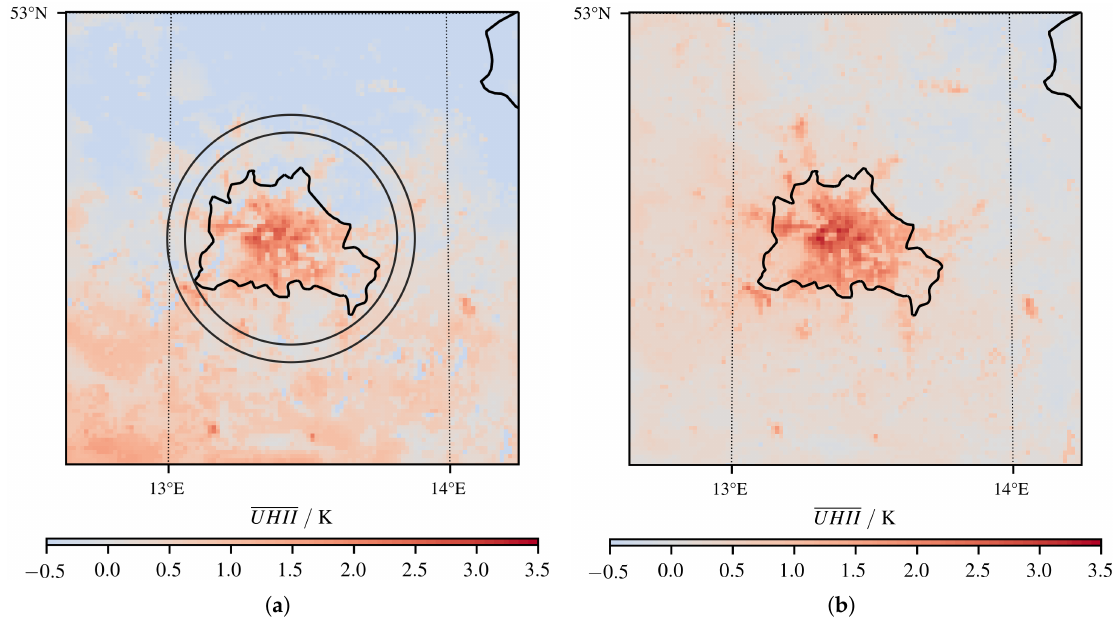
Figure 7. Time-averaged UHI intensity maps for the evaluation methods “ring rural reference” and “virtual rural reference”. ( a ) Ring rural reference. ( b ) Virtual rural